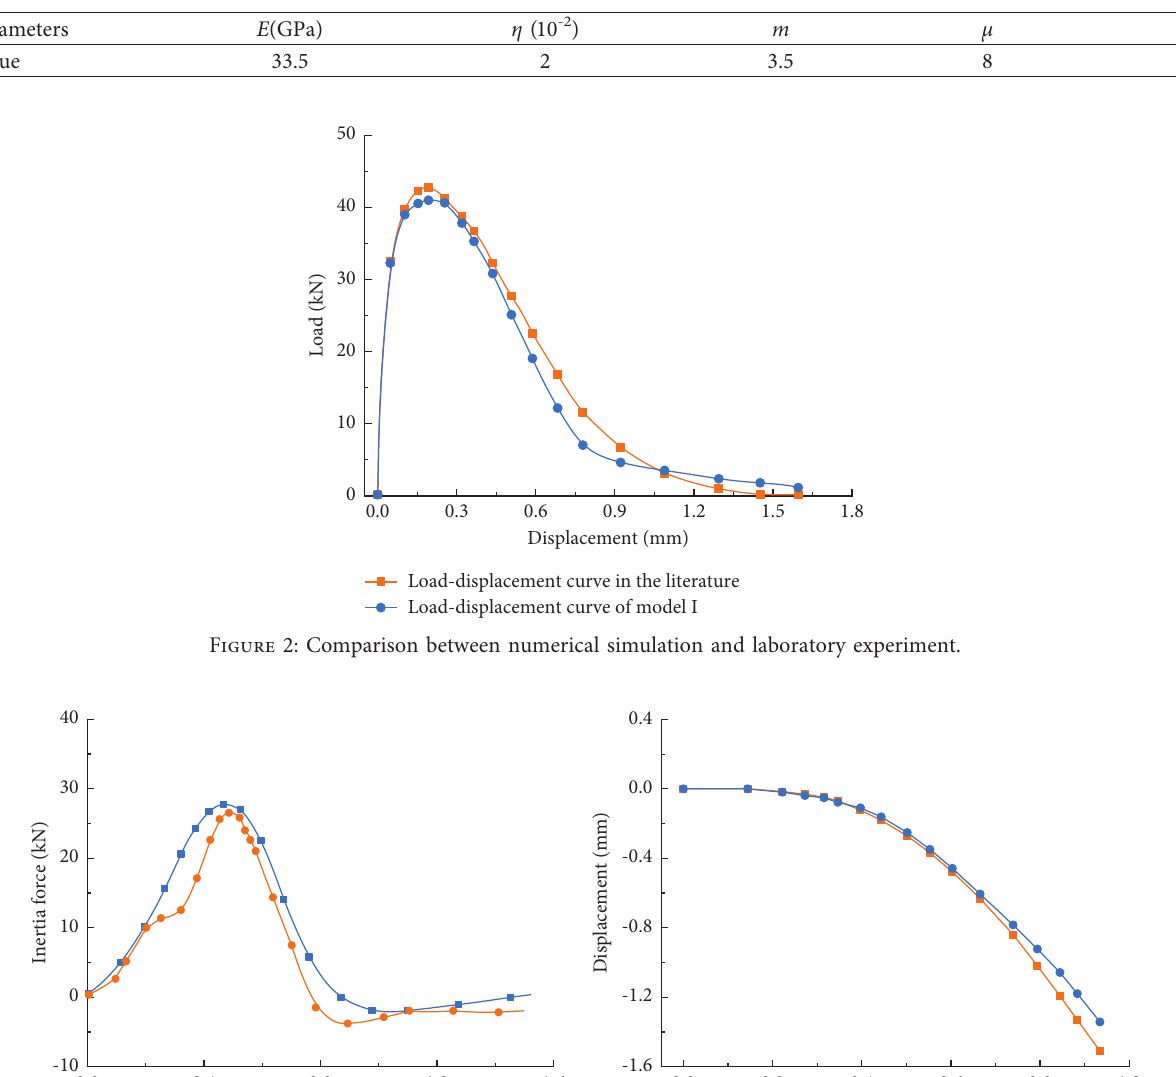
Table 1: Result of the back analysis of parameters.